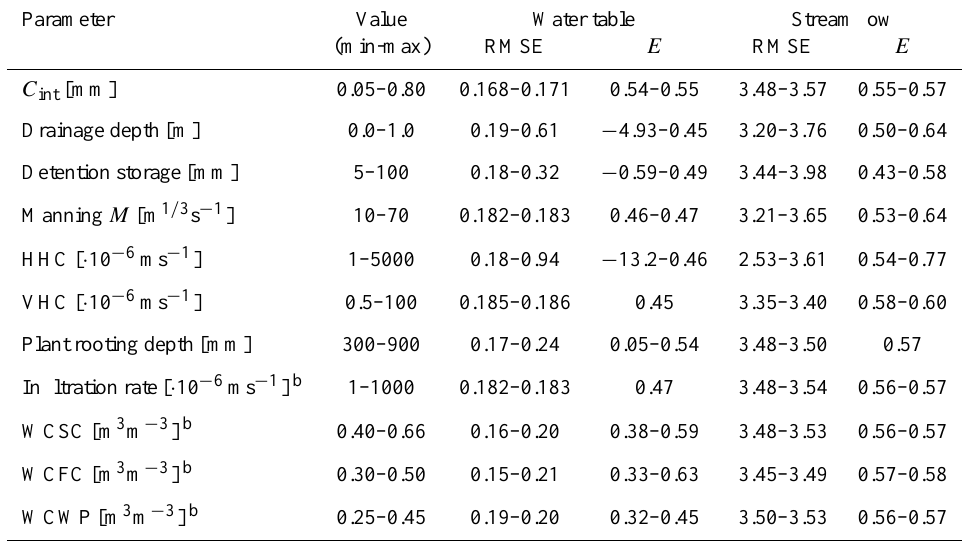
Table 3. Root mean squared error (RMSE) and Nash and Sutcliffe’s model efficiency ( E ) from calibrations for water table and streamflow a . Parameter Water